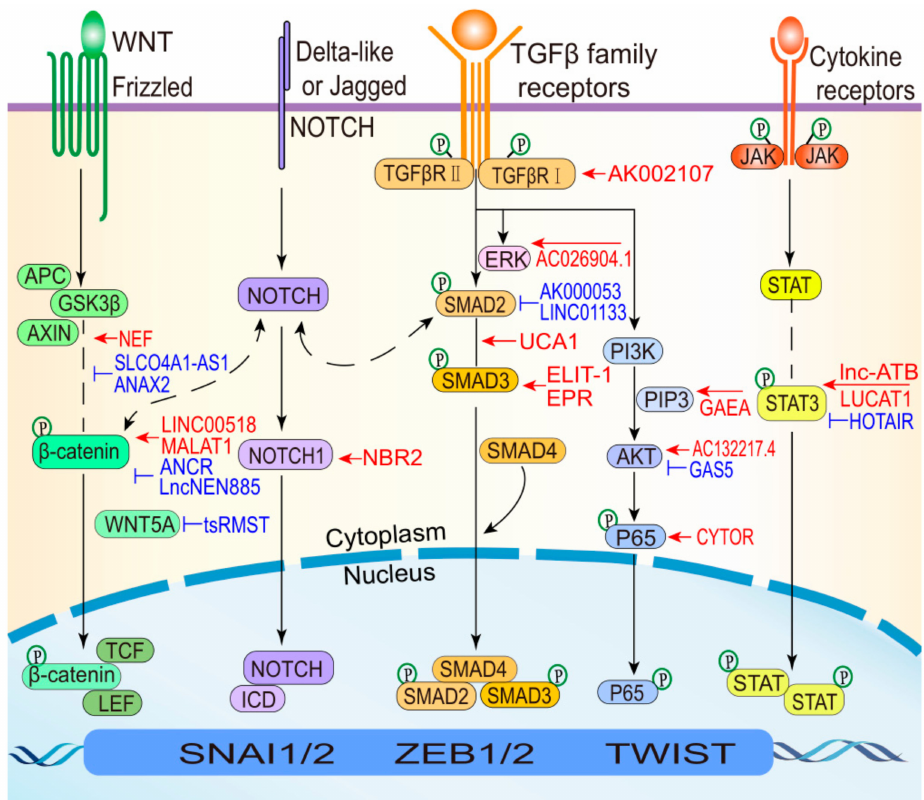
Figure 4. LncRNAs regulate EMT signaling pathways. When the canonical Wnt pathway is activated, β -catenin is released from the GSK3 β -AXIN-APC complex. Then, β -catenin translocates to the